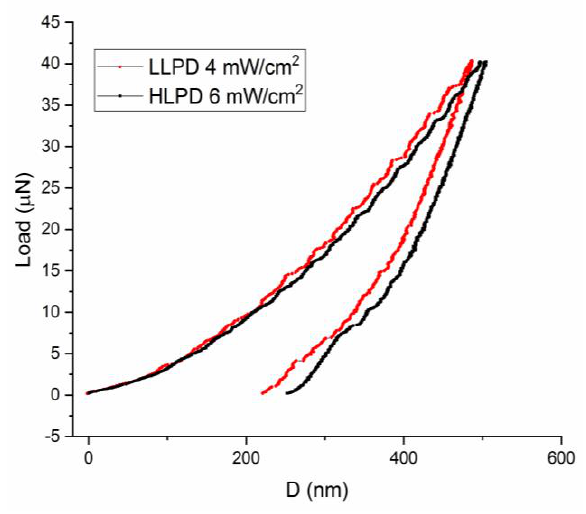
Figure 6. Load-displacement curves recorded for laser-annealed LLPD samples at 4 mWcm 2 as well as for the sample laser annealed in the HLPD mode at 6 mW/cm 2 . Table 3. The calculated values for hardness and reduced bulk modulus for the laser-annealed LLPD samples at 2.5 and 4 mW/cm 2 , as well as for the sample laser-annealed in HLPD mode at 6 mW/cm 2